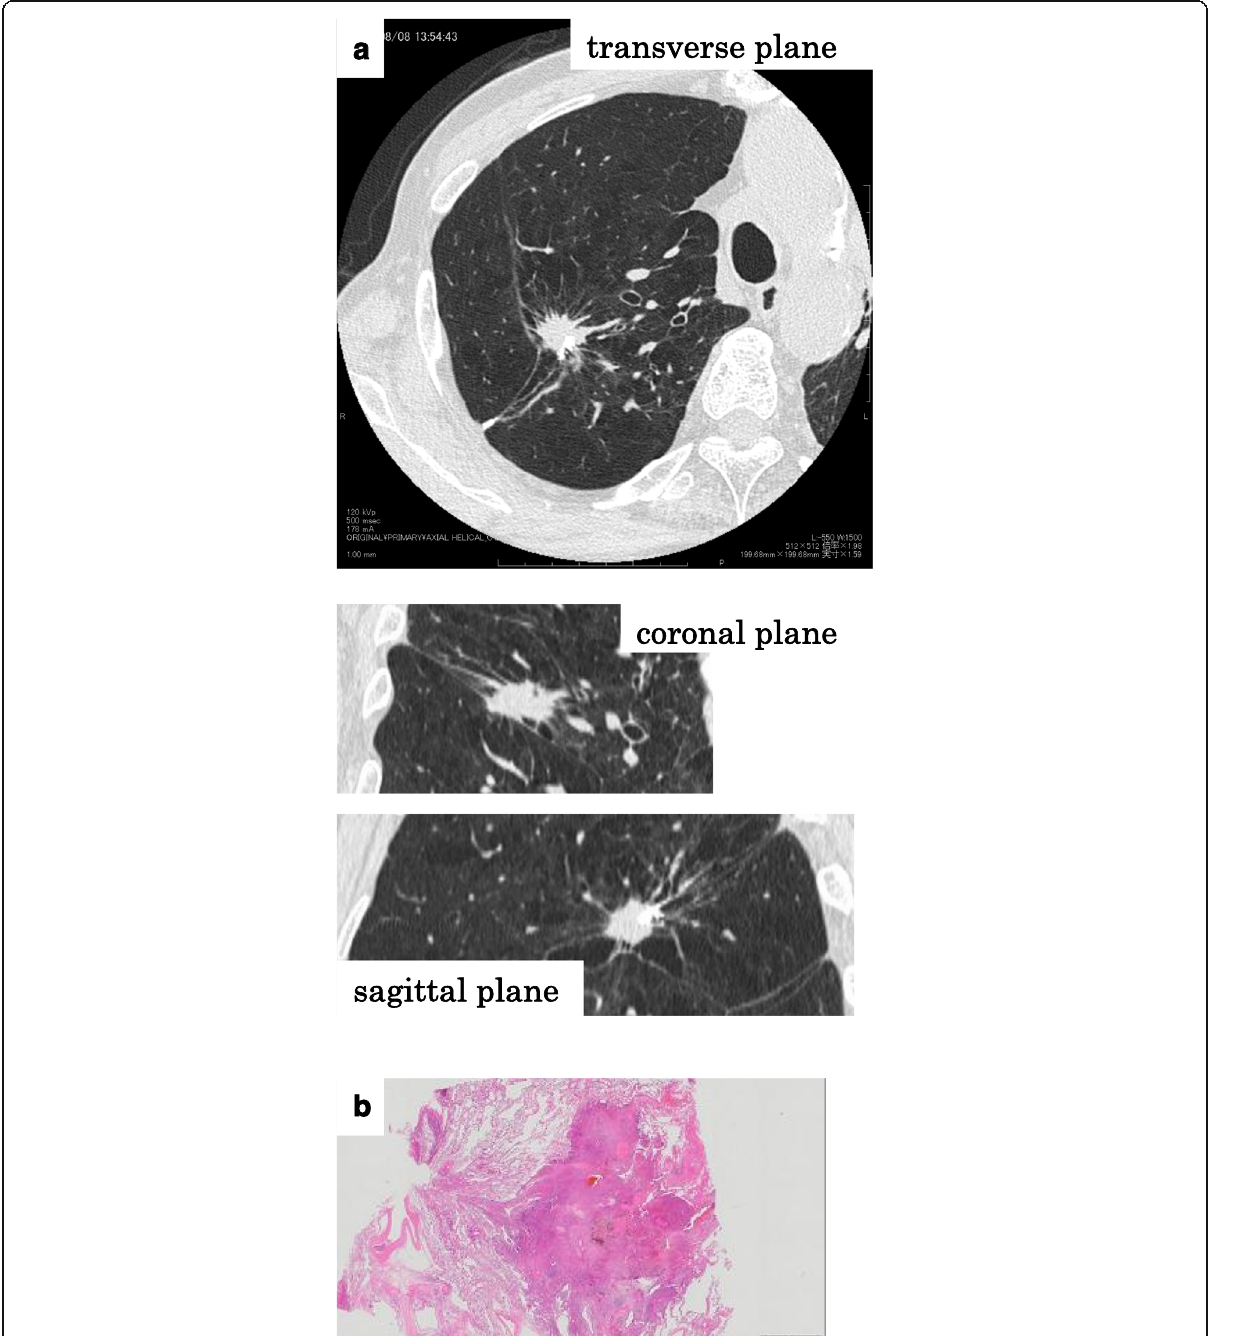
Fig. 5 a Radiographic estimation by multi-planar reconstructions (transverse, coronal, and sagittal views) on thin-slice CT images (0.1-cm slice) before reoperation. b Pathologic features of the cut-end lesion of the residual right upper lobe, showing adenocarcinoma (macroscopic